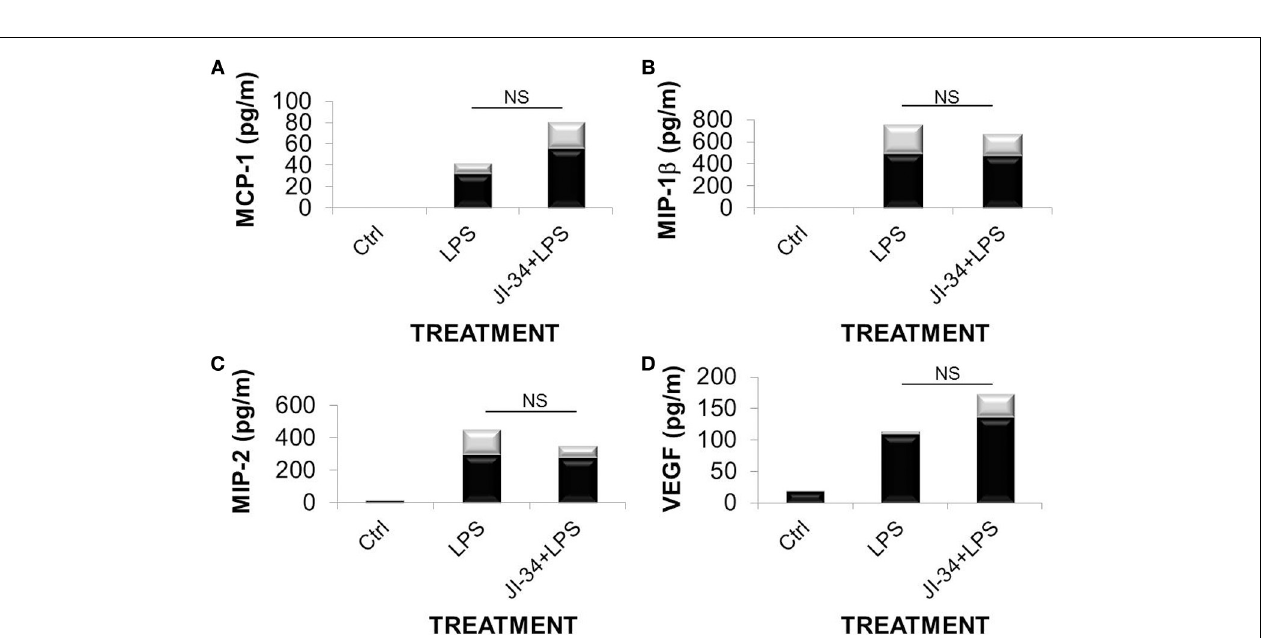
as assessed using the Multiplex MCYTOMAG-70K assay (EMD Millipore, Billerica, MA, USA). Data are presented as mean ± SD (gray bars).